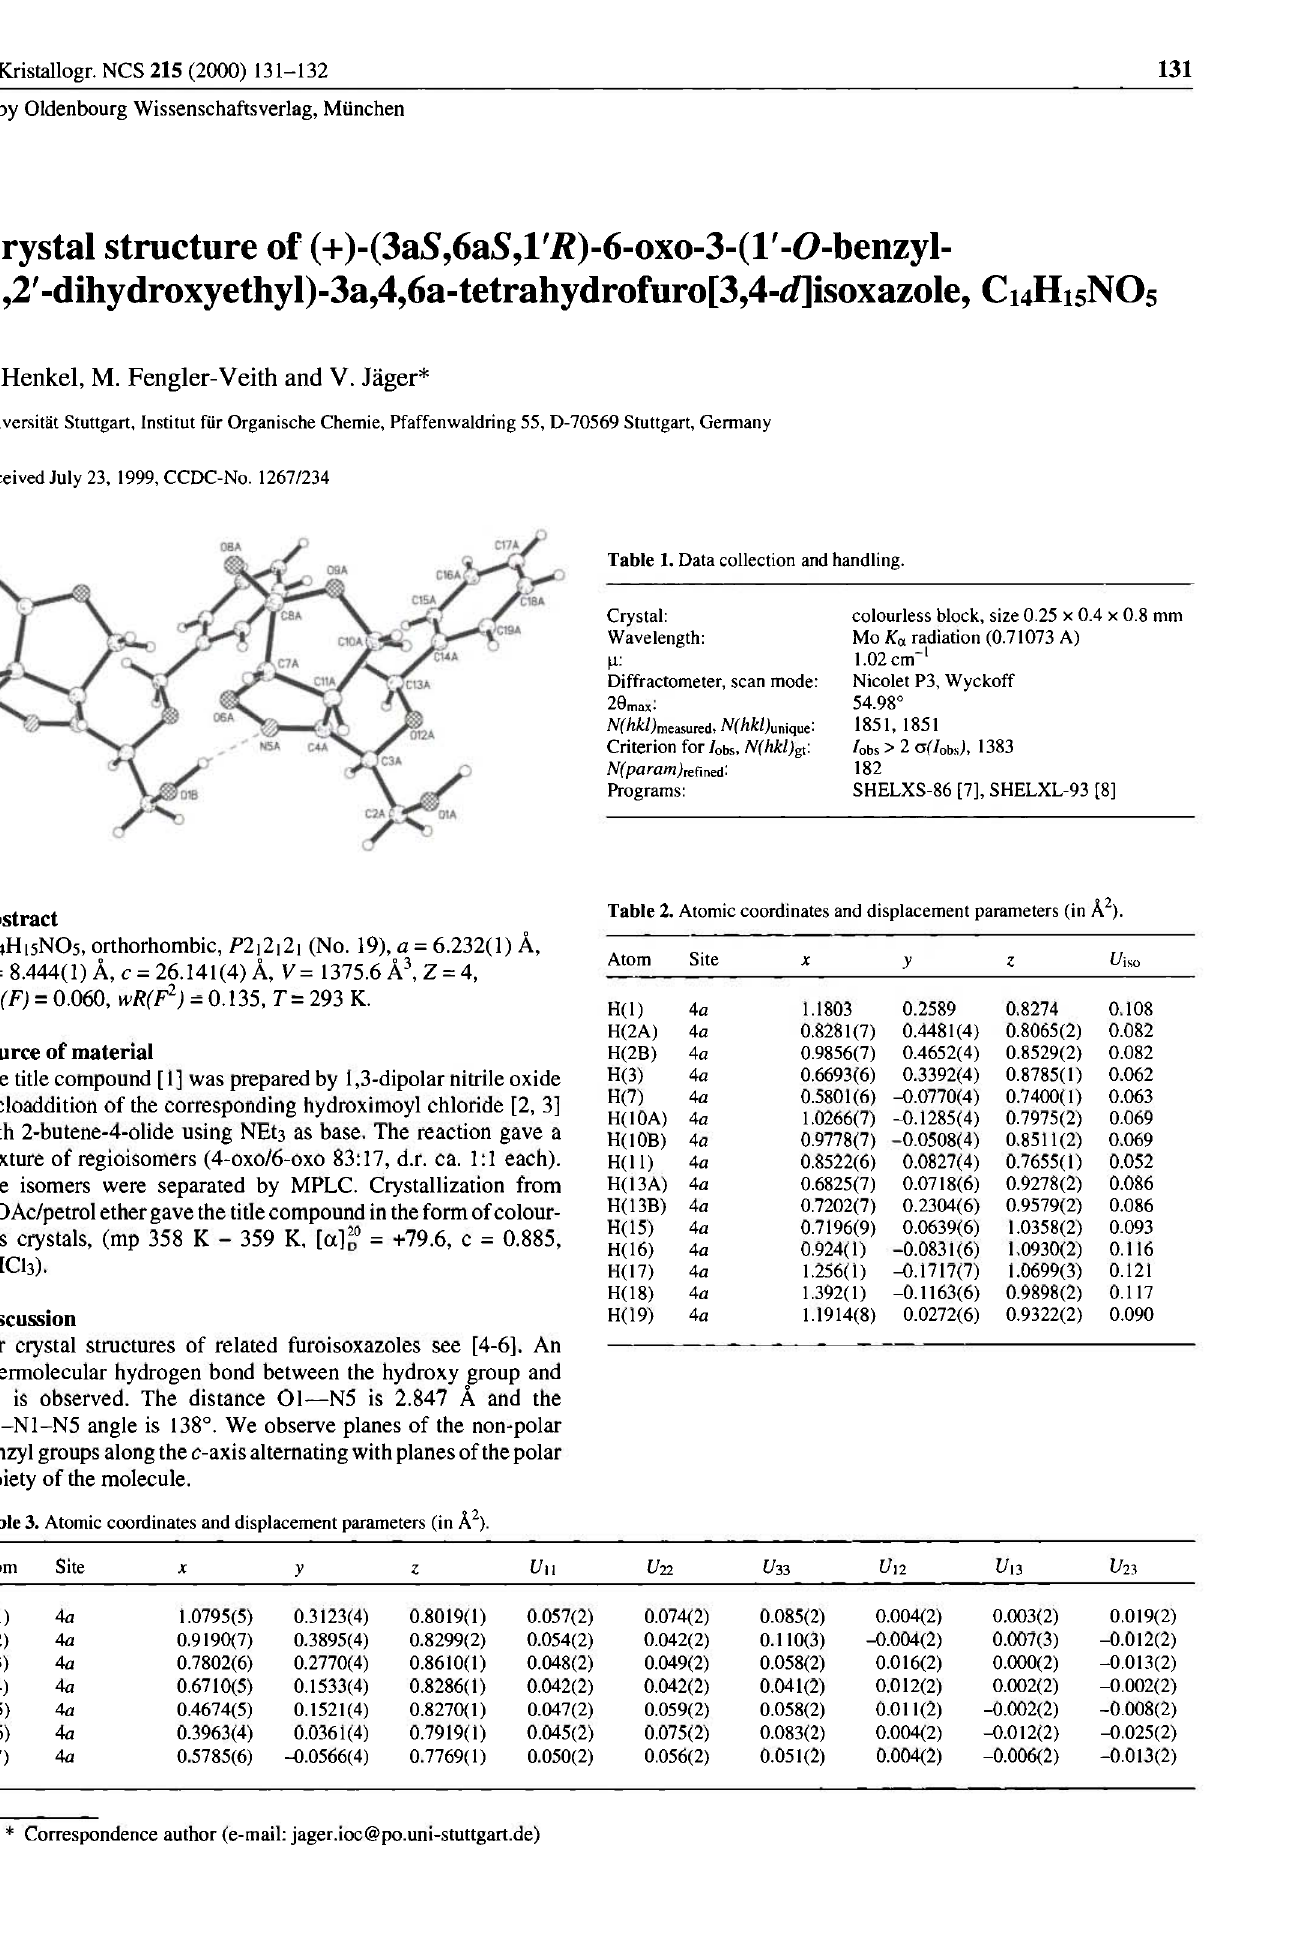
Table 3. Atomic coordinates and displacement parameters (in Ä 2